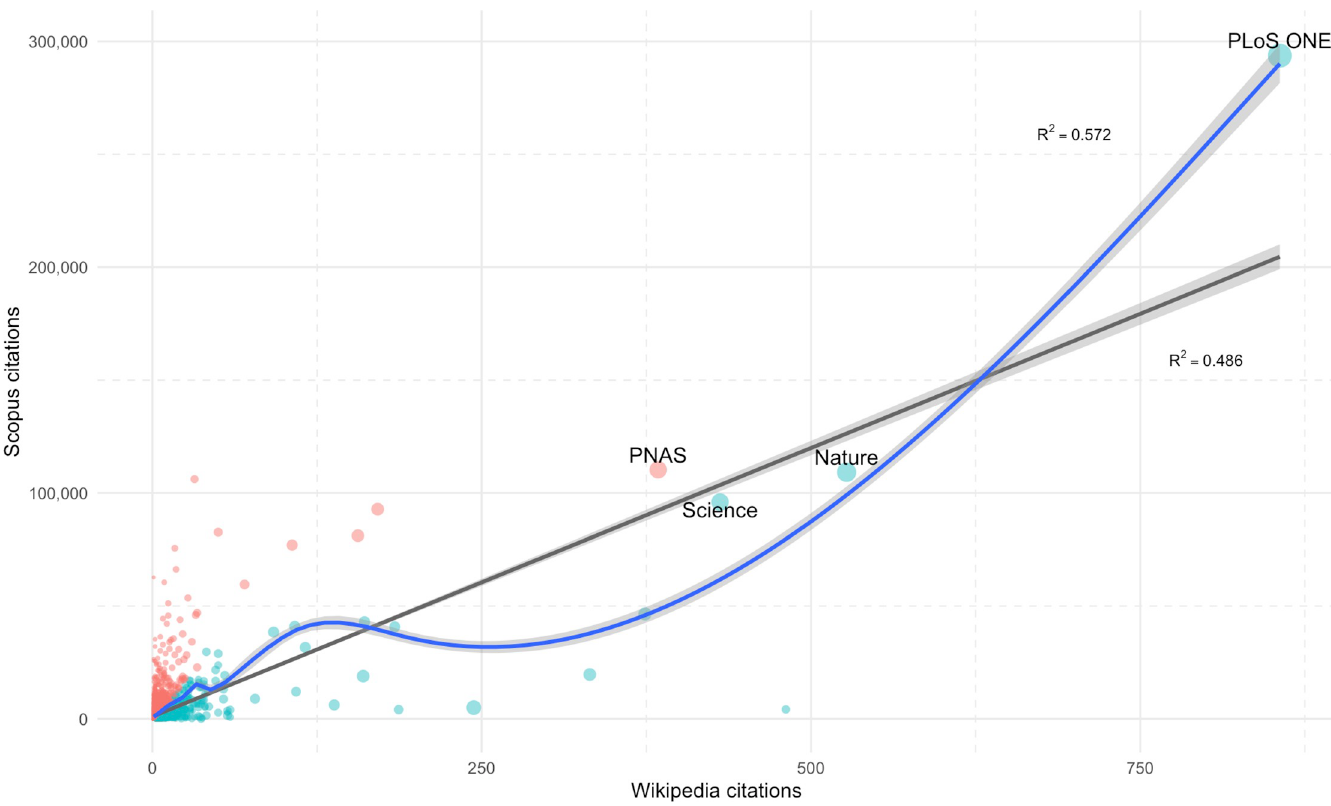
Fig 5. Scatter plot of journals by citation collected in Scopus and Wikipedia in 2016 to articles published between 2013 and 2015. The size of the points corresponds to the number of articles published in that period and the color corresponds to the ratio between citation percentiles: red (more on Scopus) and blue (more on